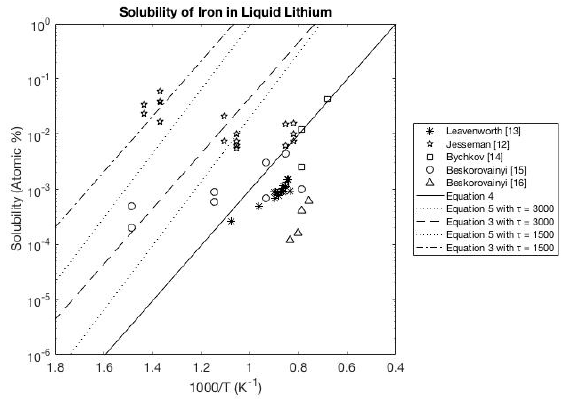
Figure 3. Solubility of iron in liquid lithium.